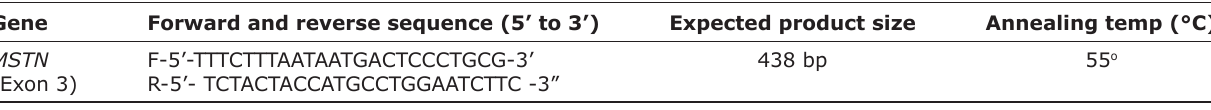
Table-1: Primer sequences used to amplify myostatin gene. Gene